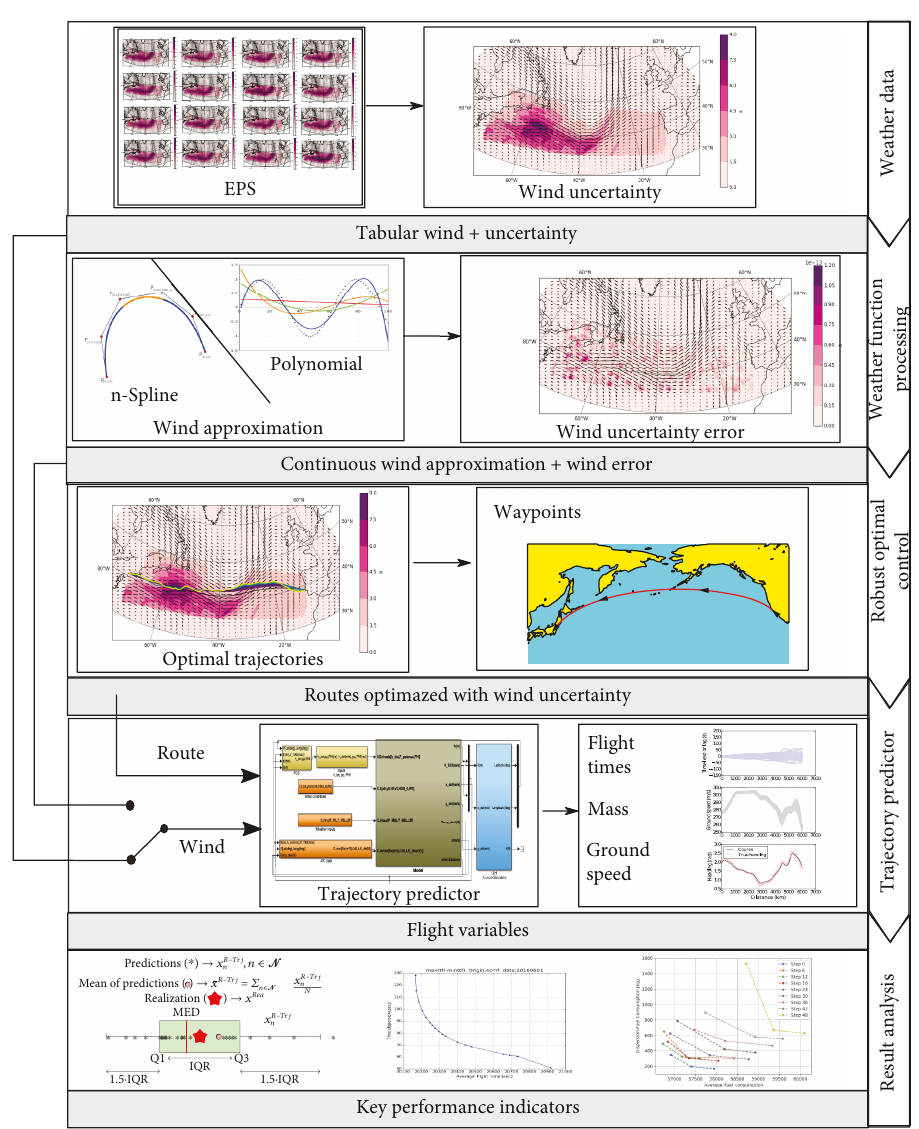
Figure 1: Methodological